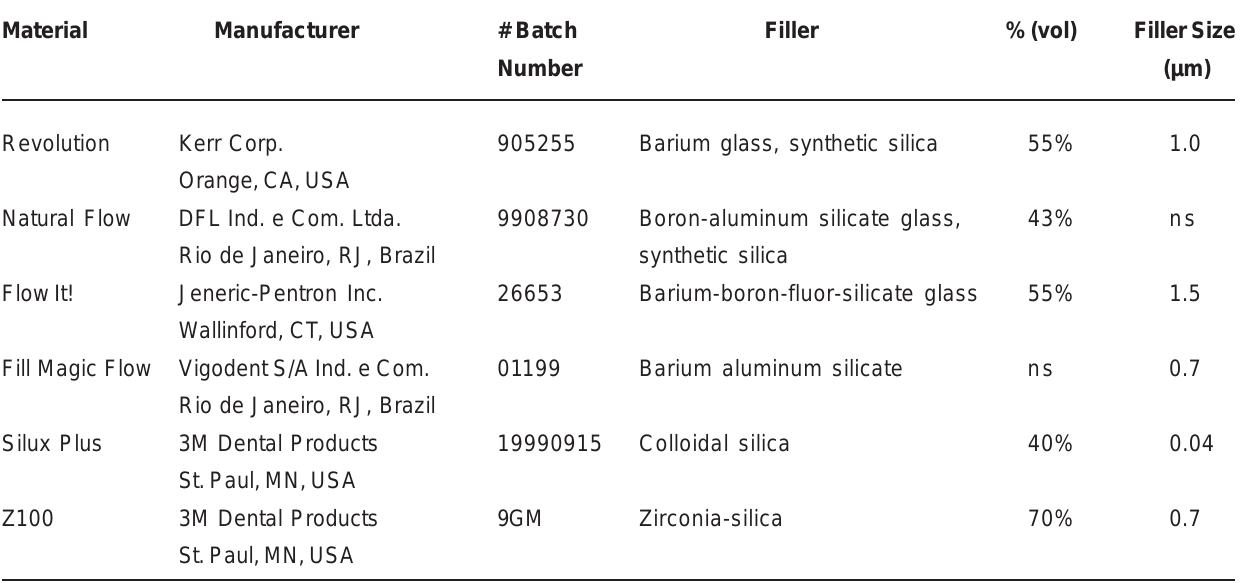
ns–not supplied by the